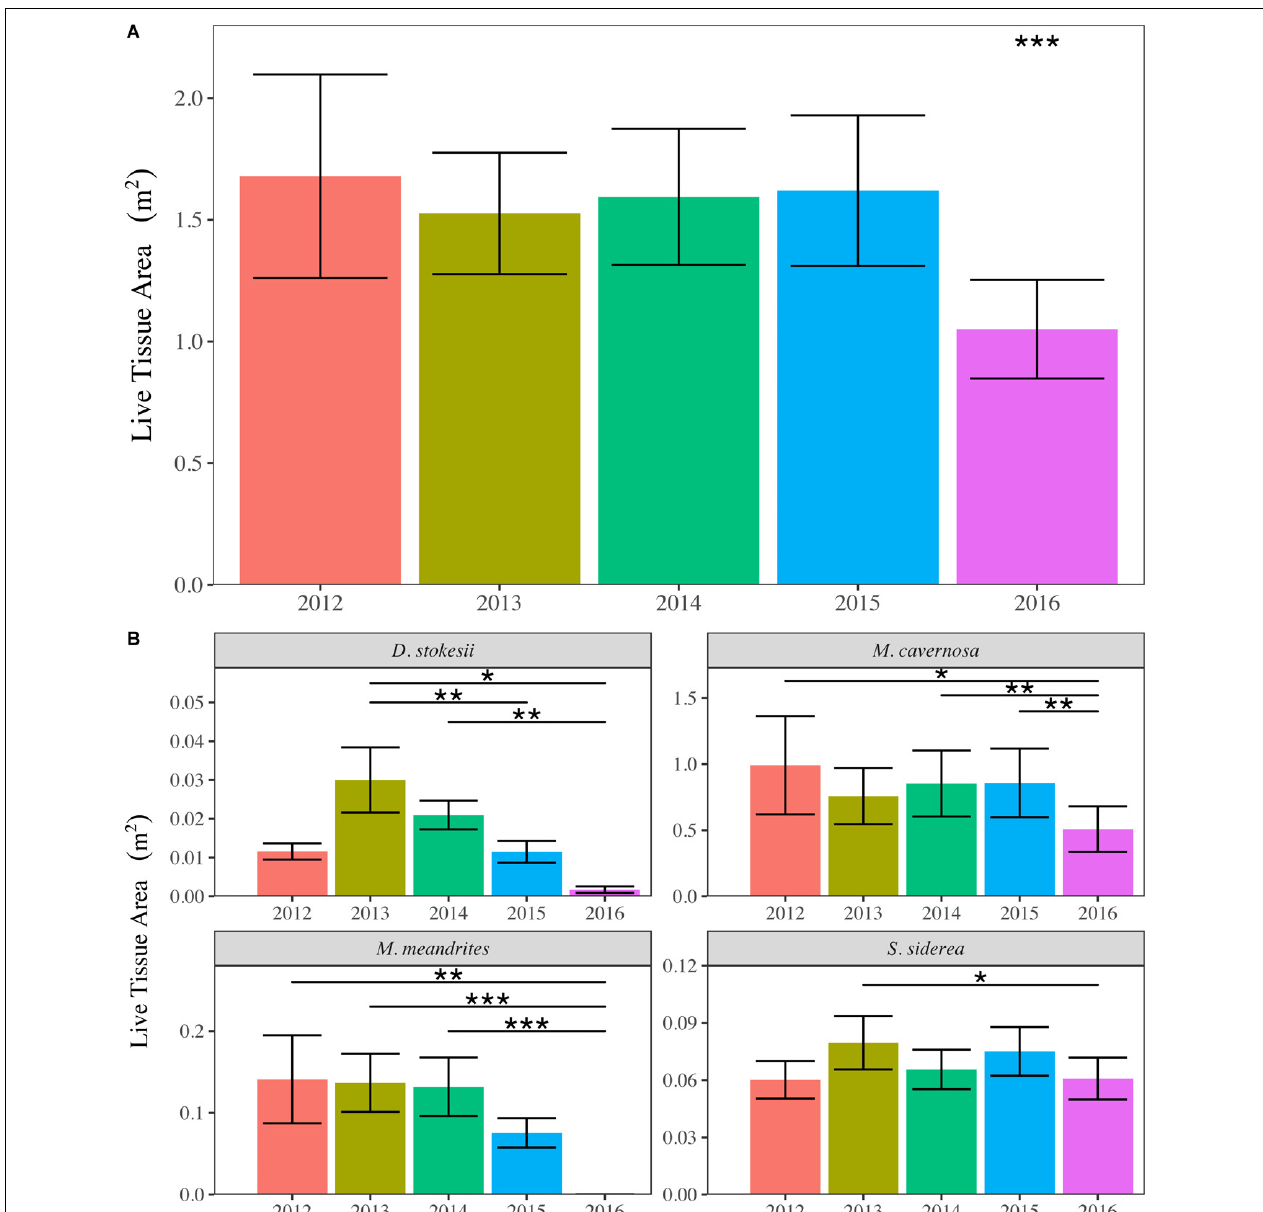
FIGURE 7 | Annual mean ( ± SE) stony coral live tissue area (LTA) for the SECREMP (A) region and (B) coral species with significant declines due to white syndrome. Regional LTA in 2016 was significantly less than all other years. Asterisks indicated significant differences between years and the bars below the asterisks indicate the pairwise comparisons. ∗ p < 0.05; ∗∗ p < 0.01; ∗∗∗ p <